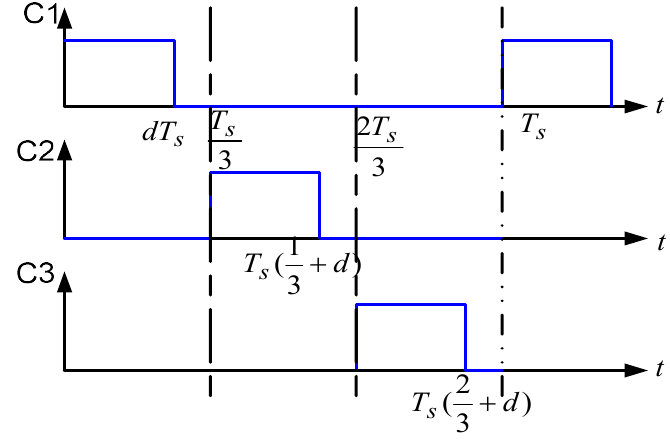
Figure 8. Operating waveforms of the switches.